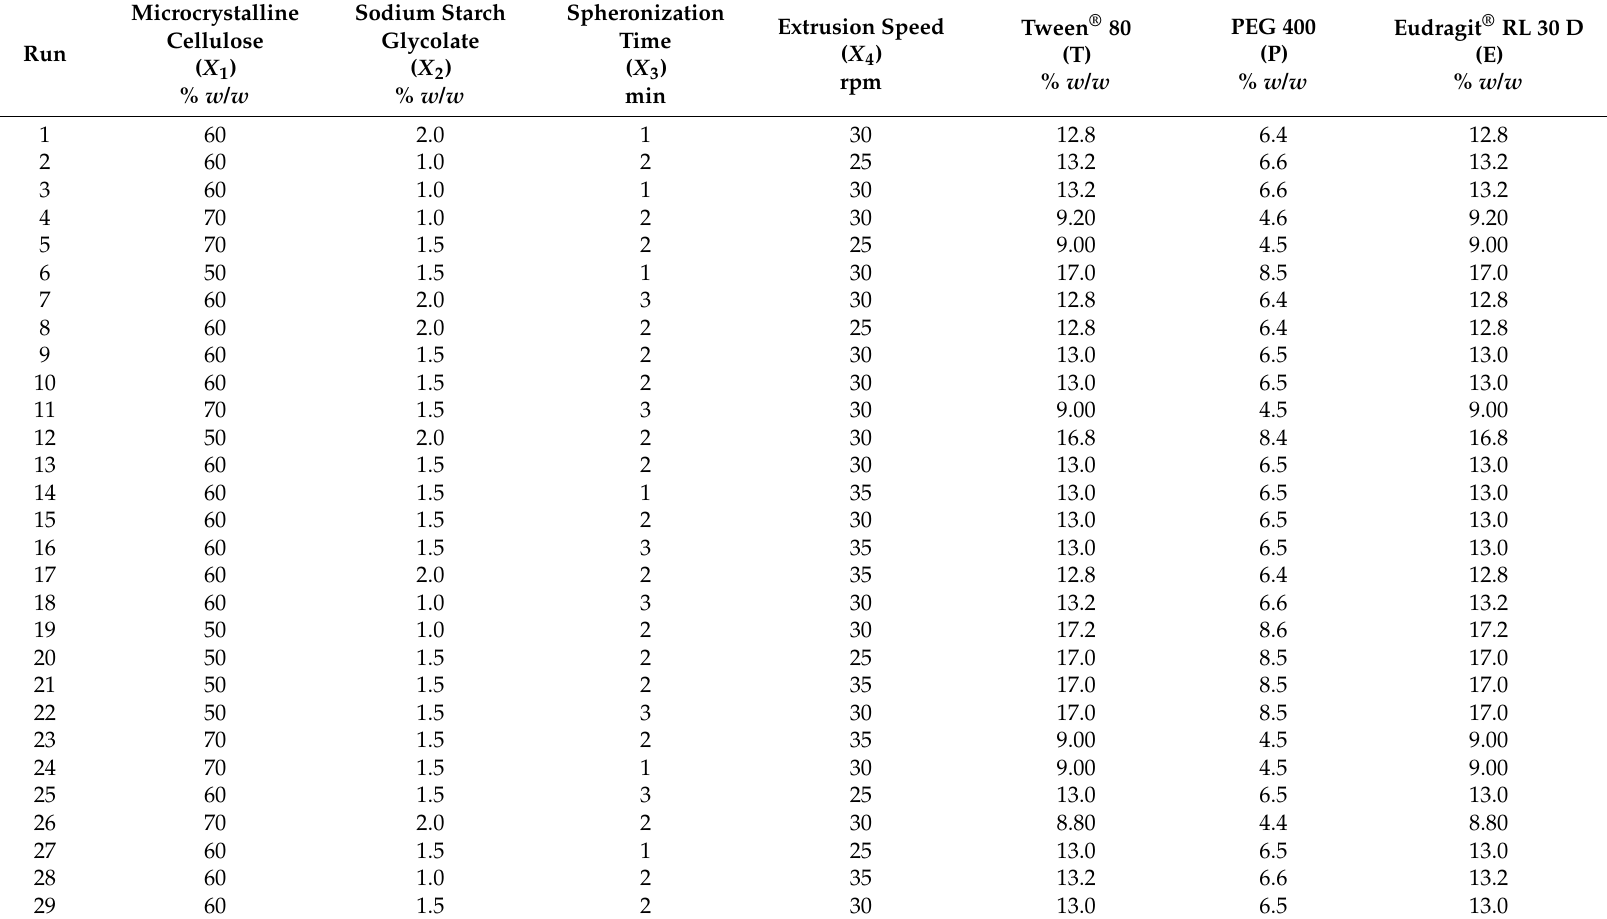
Table 1. Formulation and process variables used to manufacture prednisone